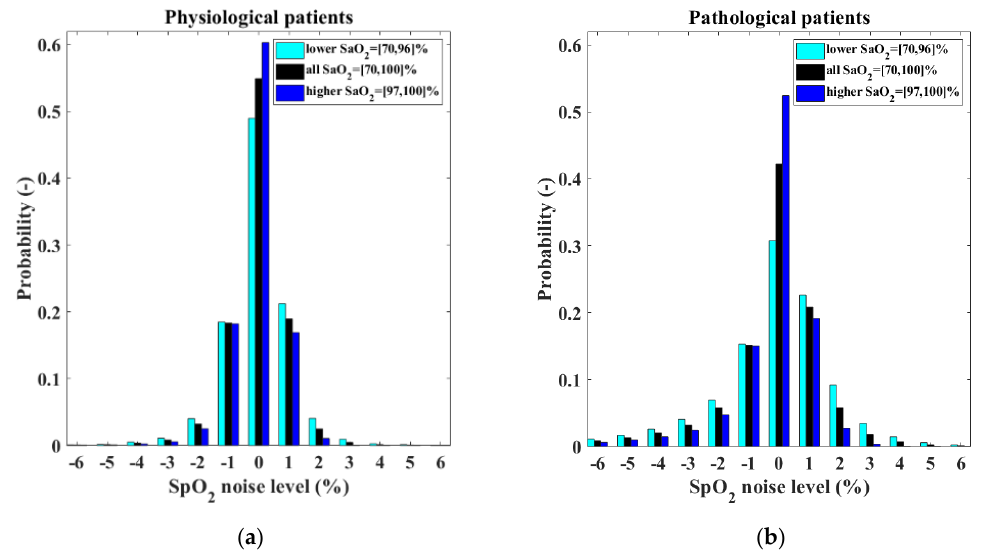
Figure 8. Normalized histograms of the SpO 2 measurement noise shows different characteristics for ( a ) physiological neonates and ( b ) pathological neonates.